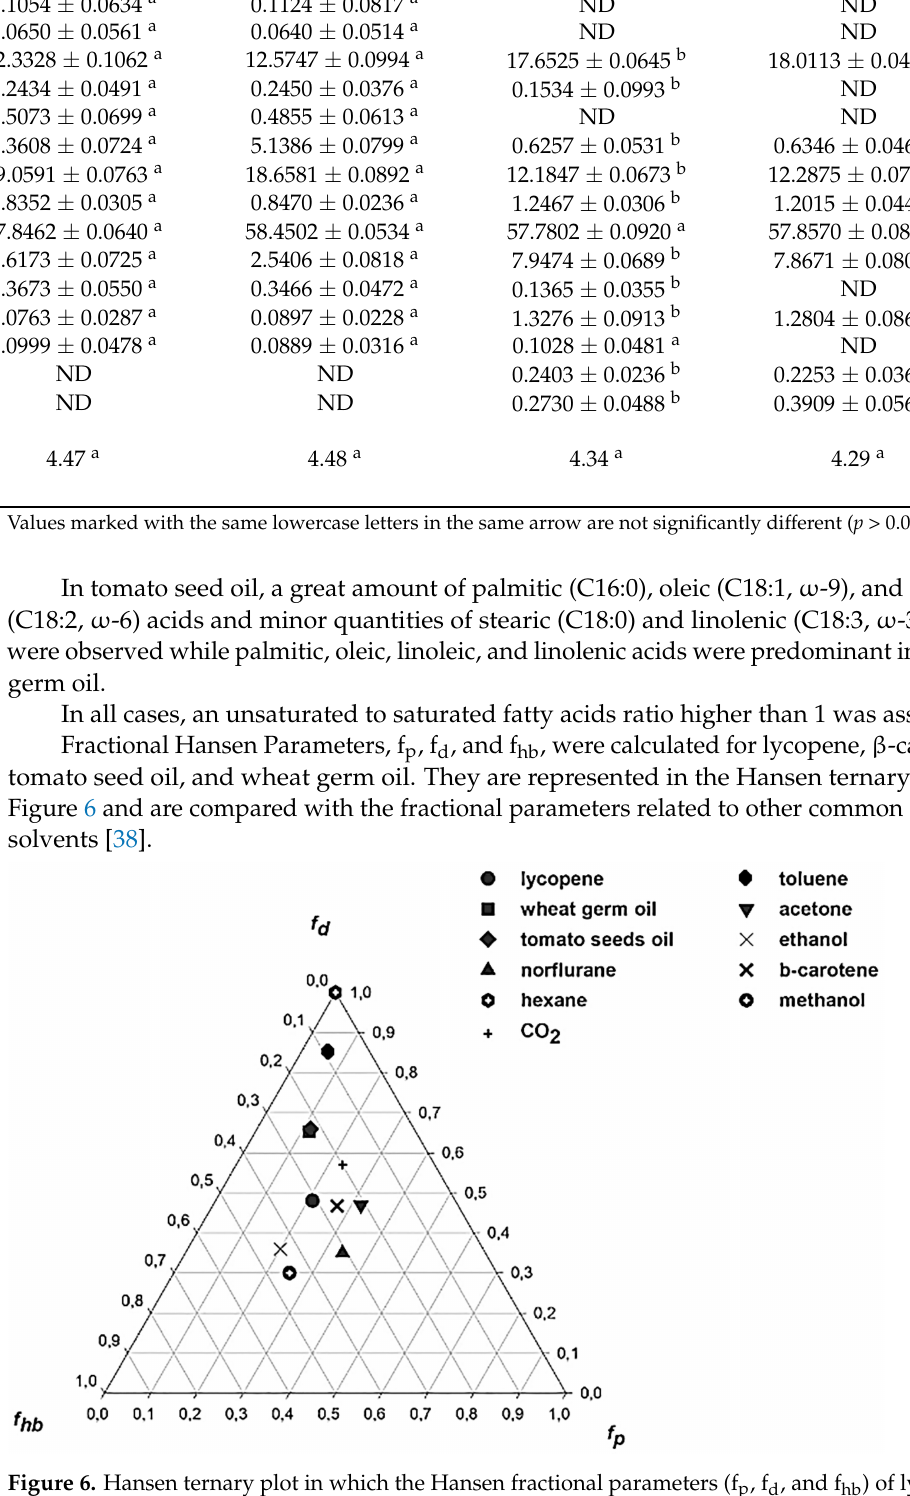
Figure 6. Hansen ternary plot in which the Hansen fractional parameters (f p , f d , and f hb ) of lycopene, tomato seeds oil, wheat germ oil, and Norflurane are represented and compared with other